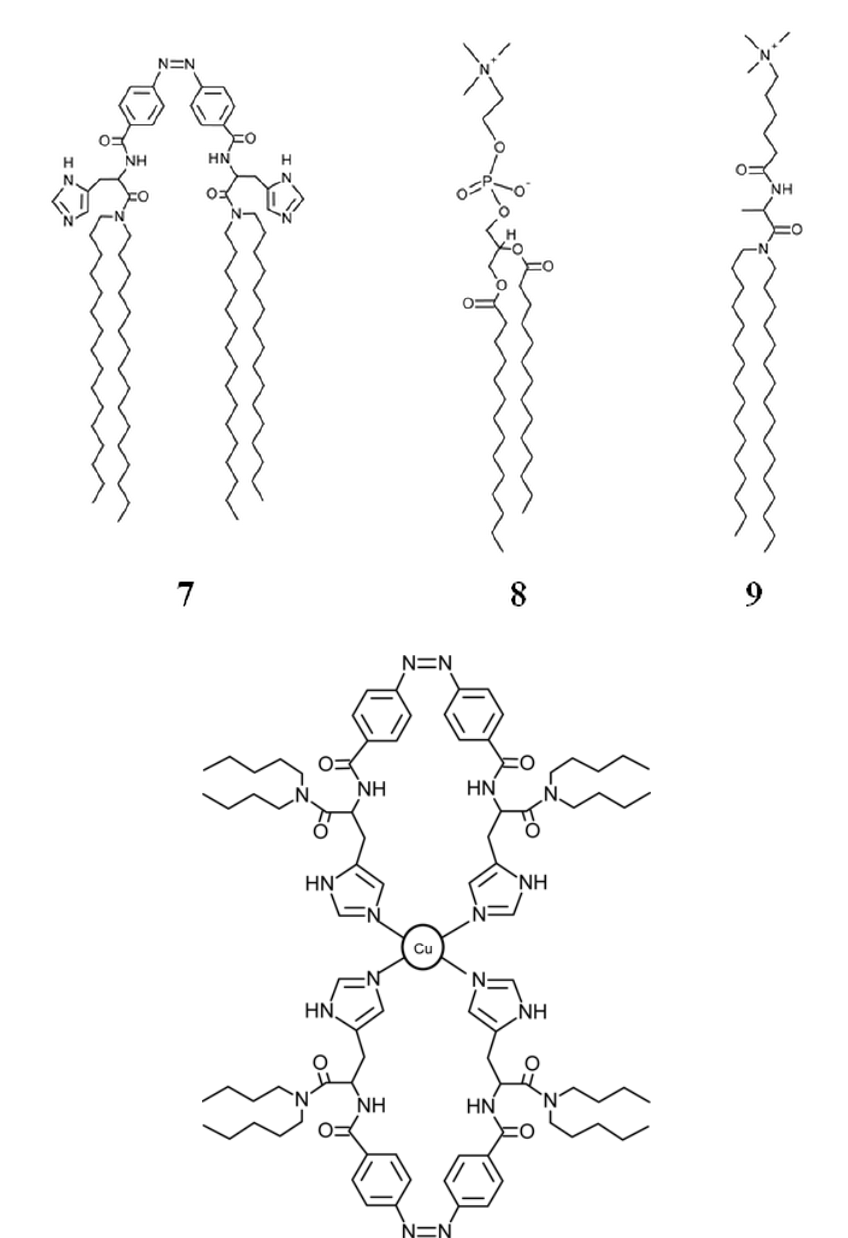
Figure 37. Structural formulas of lipids used in [256] and metal chelates induced by UV irradiation.